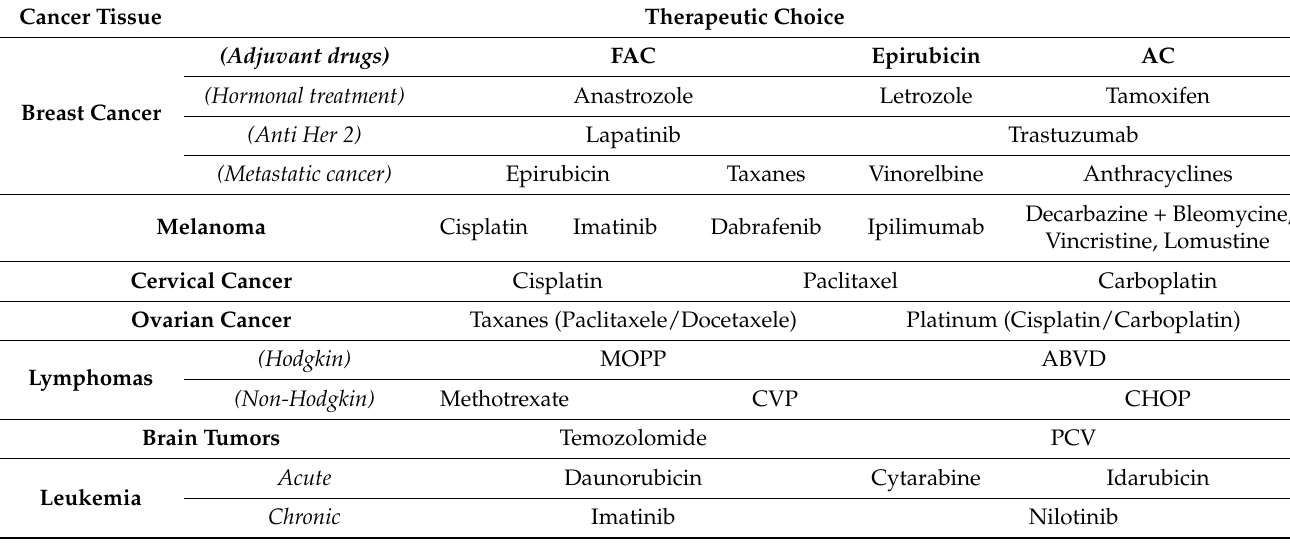
Table 1. Treatment options during pregnancy according to cancer type.